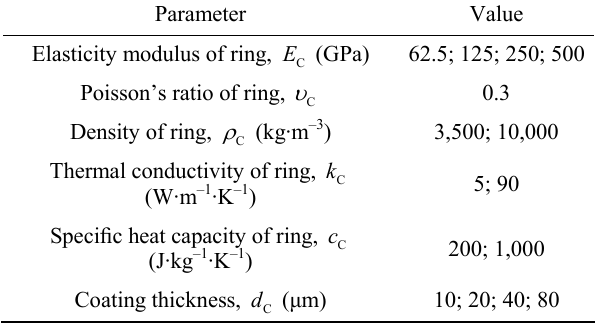
Table 4 The mechanical/thermal properties for coatings.